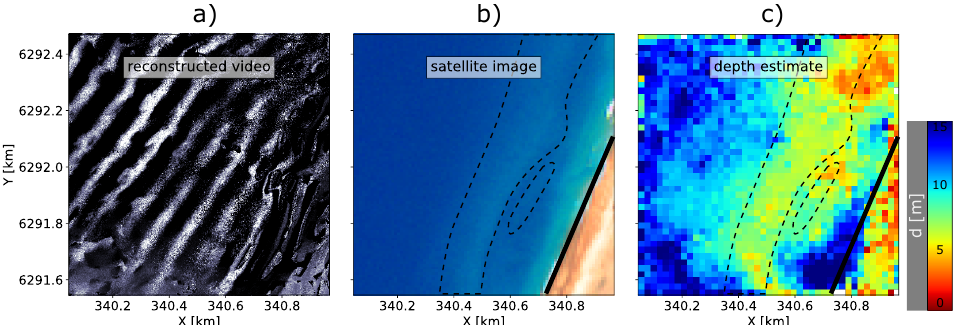
Figure 9. Sandbars from depth inversion of a locally reconstructed video of the nearshore wave field: ( a ) reconstructed video with framerate of 2fps; ( b ) satellite image showing the position of the sandbar; ( c ) depth estimates based on ( a ); For reference, dashed black contours outline the position of the sandbar. and the solid black line indicates the position of the